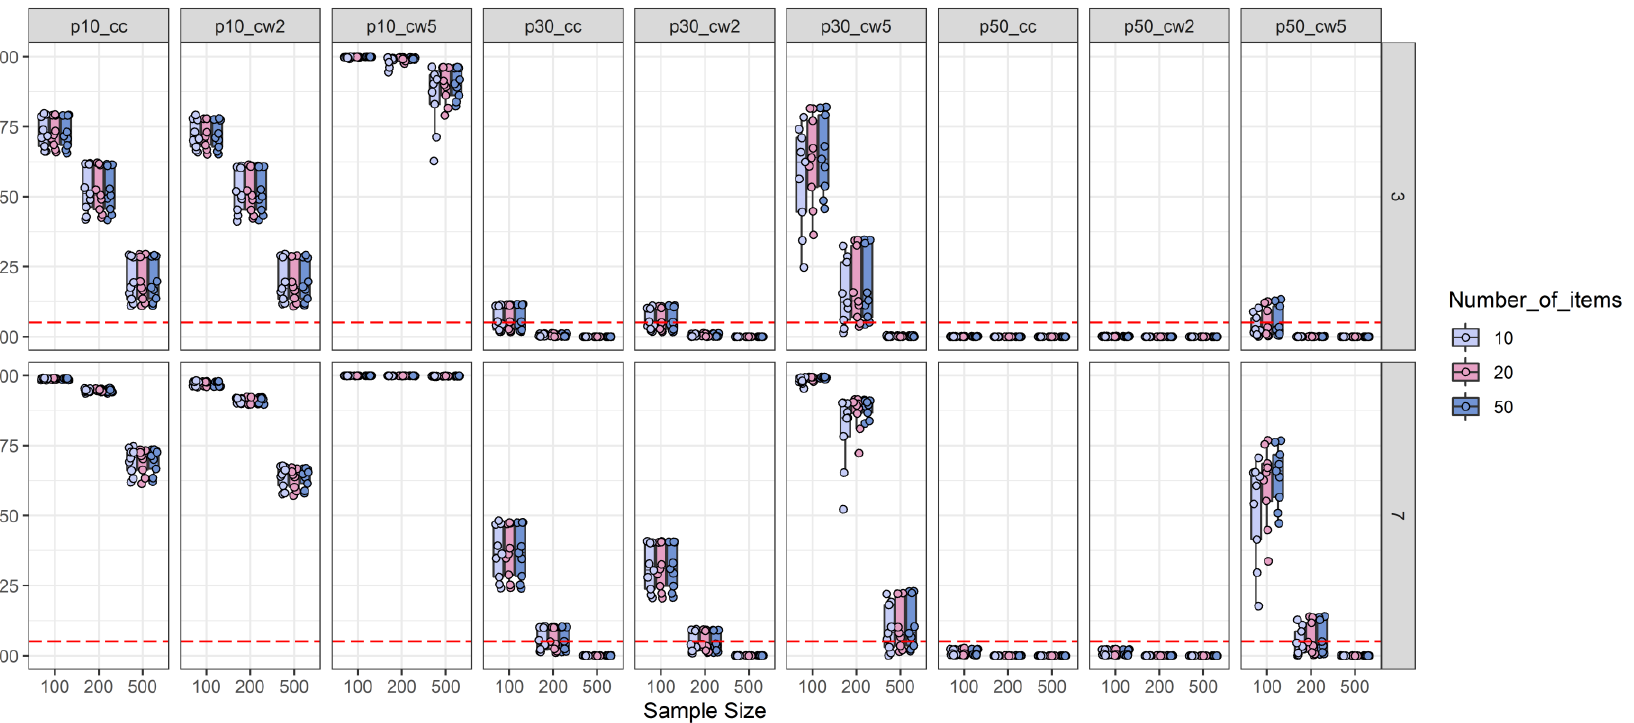
Figure A2. Number-of-items split of type-I-error analysis: Depiction of the type-I-error rate (y-axis) as a function of sample size (x-axis), number of distractors (three distractors = top-row; seven distractors = bottom-row), number of items and effect size measures combined with effect size thresholds. The horizontal red dashed line represents the target type-I-error rate of 0.05. For more explanations, see Figure 2.